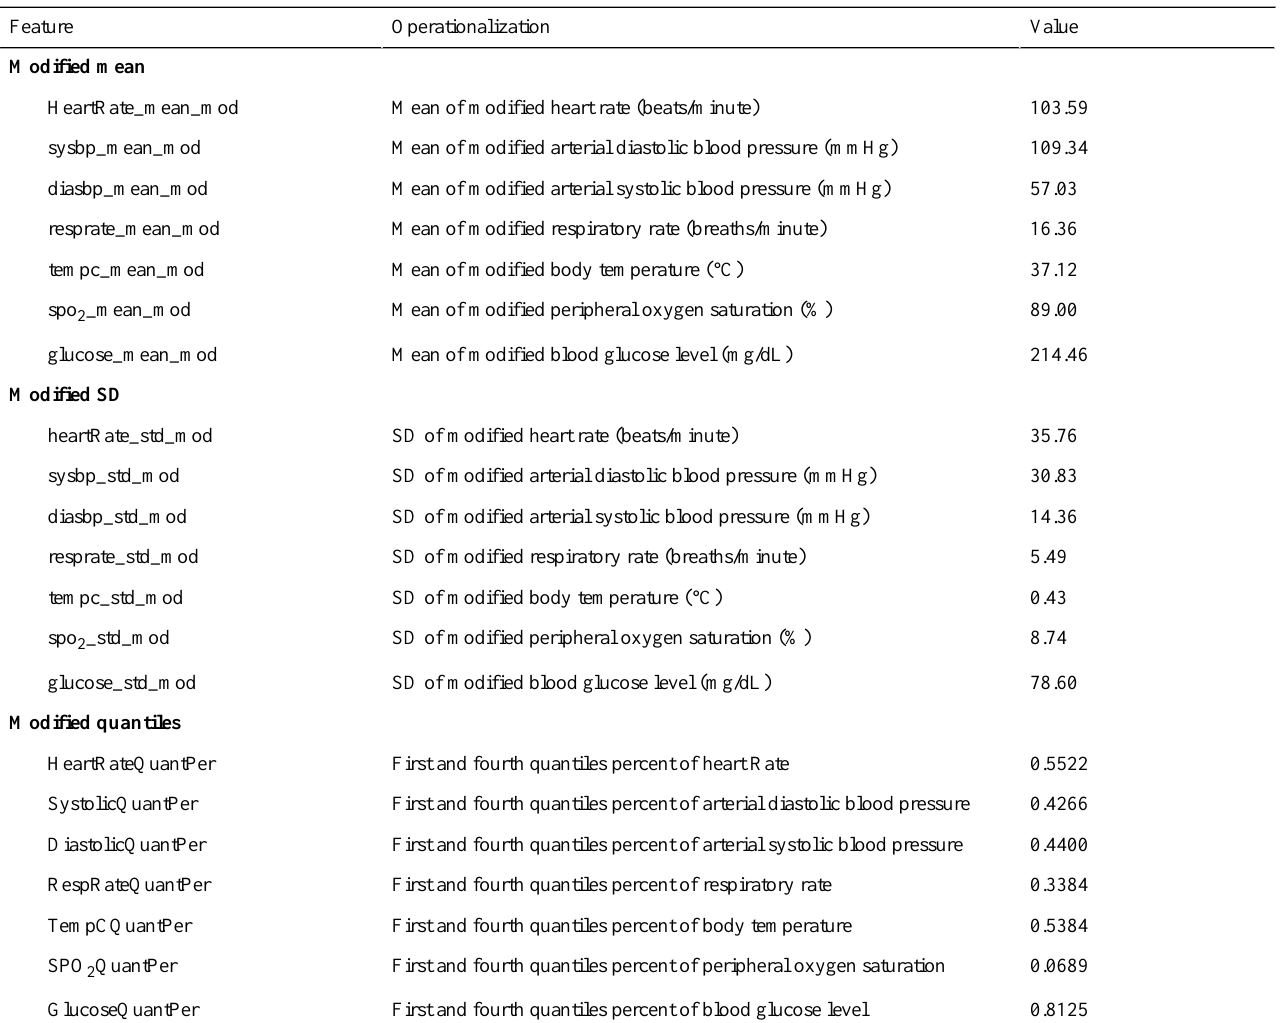
Table 5. Sample of patient data from after applying the quantiles